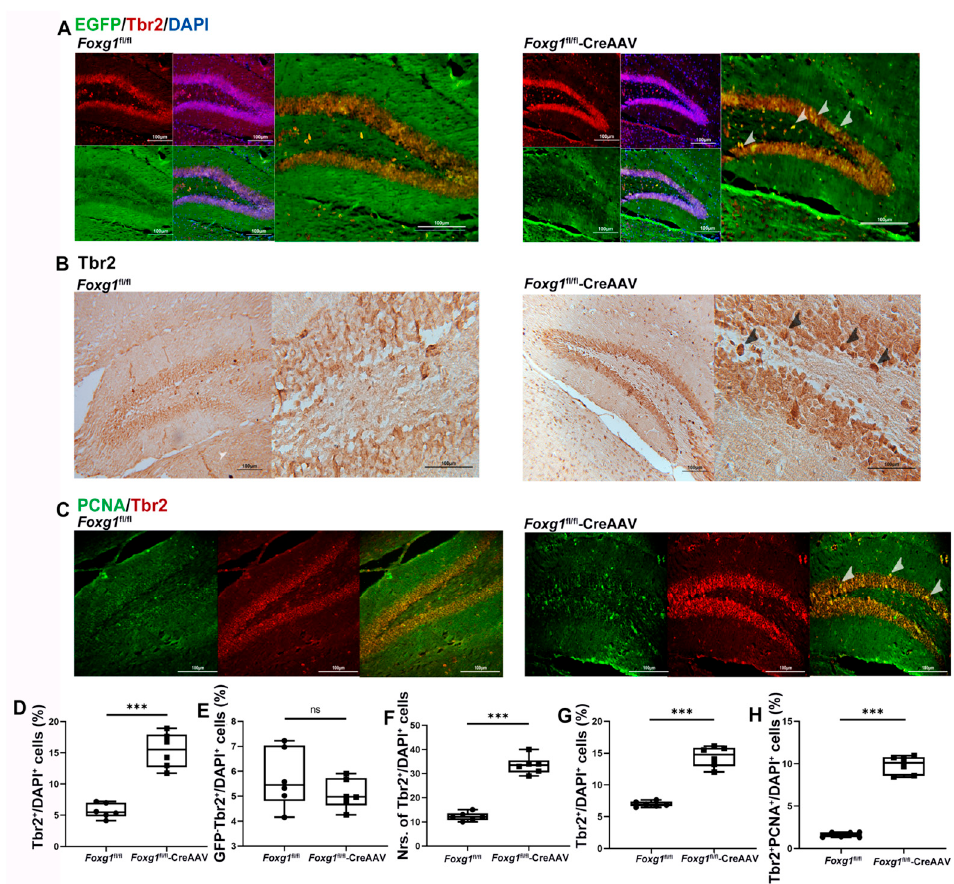
Figure 4. FOXG1 increases the amount of Tbr2-expressing IPCs and promotes their proliferation in adult hippocampal DG of the Foxg1 genotype mice. ( A ) Expression patterns of Tbr2-expressing IPCs in the hippocampal DG of Foxg1 fl/fl mice were assessed with immunofluorescence. Red = Tbr2; Green = EGFP-labeled FOXG1; Blue = DAPI. Scale bars = 100 μ m. Arrow heads: newly generated IPCs with FOXG1 activation. ( D ) Levels of total intermediate progenitor cells (IPCs) in adult hippocampus are showed as %Tbr2 + /DAPI + cells. ( E ) Levels of endogenous IPCs in adult hippocampus are showed as %GFP - Tbr2 + /DAPI + cells. ( B ) Expression patterns and ( F ) qualification of total IPCs in adult hippocampus were studied with immunohischemisitry. Scale bars = 100 μ m. ( C ) Expression patterns of proliferated IPCs in the hippocampal DG of Foxg1 genotype mice were assessed with immunofluorescence. Red = Tbr2; Green = PCNA. Scale bars = 100 μ m. Arrow heads: proliferated IPCs. ( G ) Levels of IPCs in adult hippocampus are showed as %Tbr2 + /DAPI + cells. ( H ) Levels of proliferated IPCs in adult hippocampus are showed as %Tbr2 + PCNA + /DAPI + cells. Values are expressed as means ± S. E. M. n = 6/group. Significant levels set at *** p < 0.001 noted difference between Foxg1 fl/fl and Foxg1 fl/fl -CreAAV animals. ns—not significant.